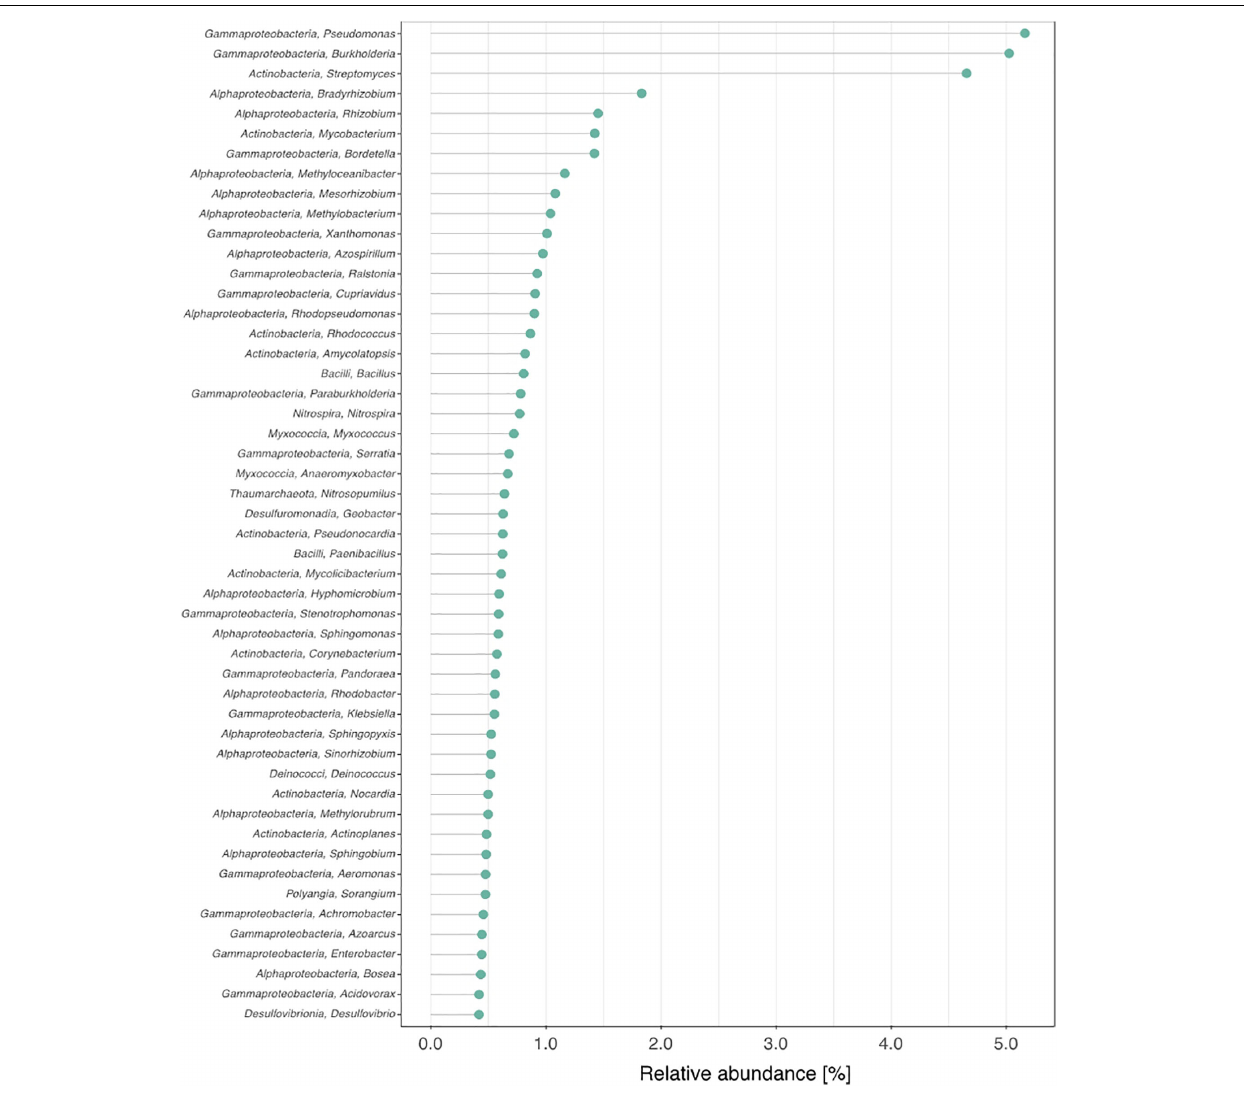
FIGURE 2 | Fifty most abundant microbial genera and their relative abundances in the activated sludge